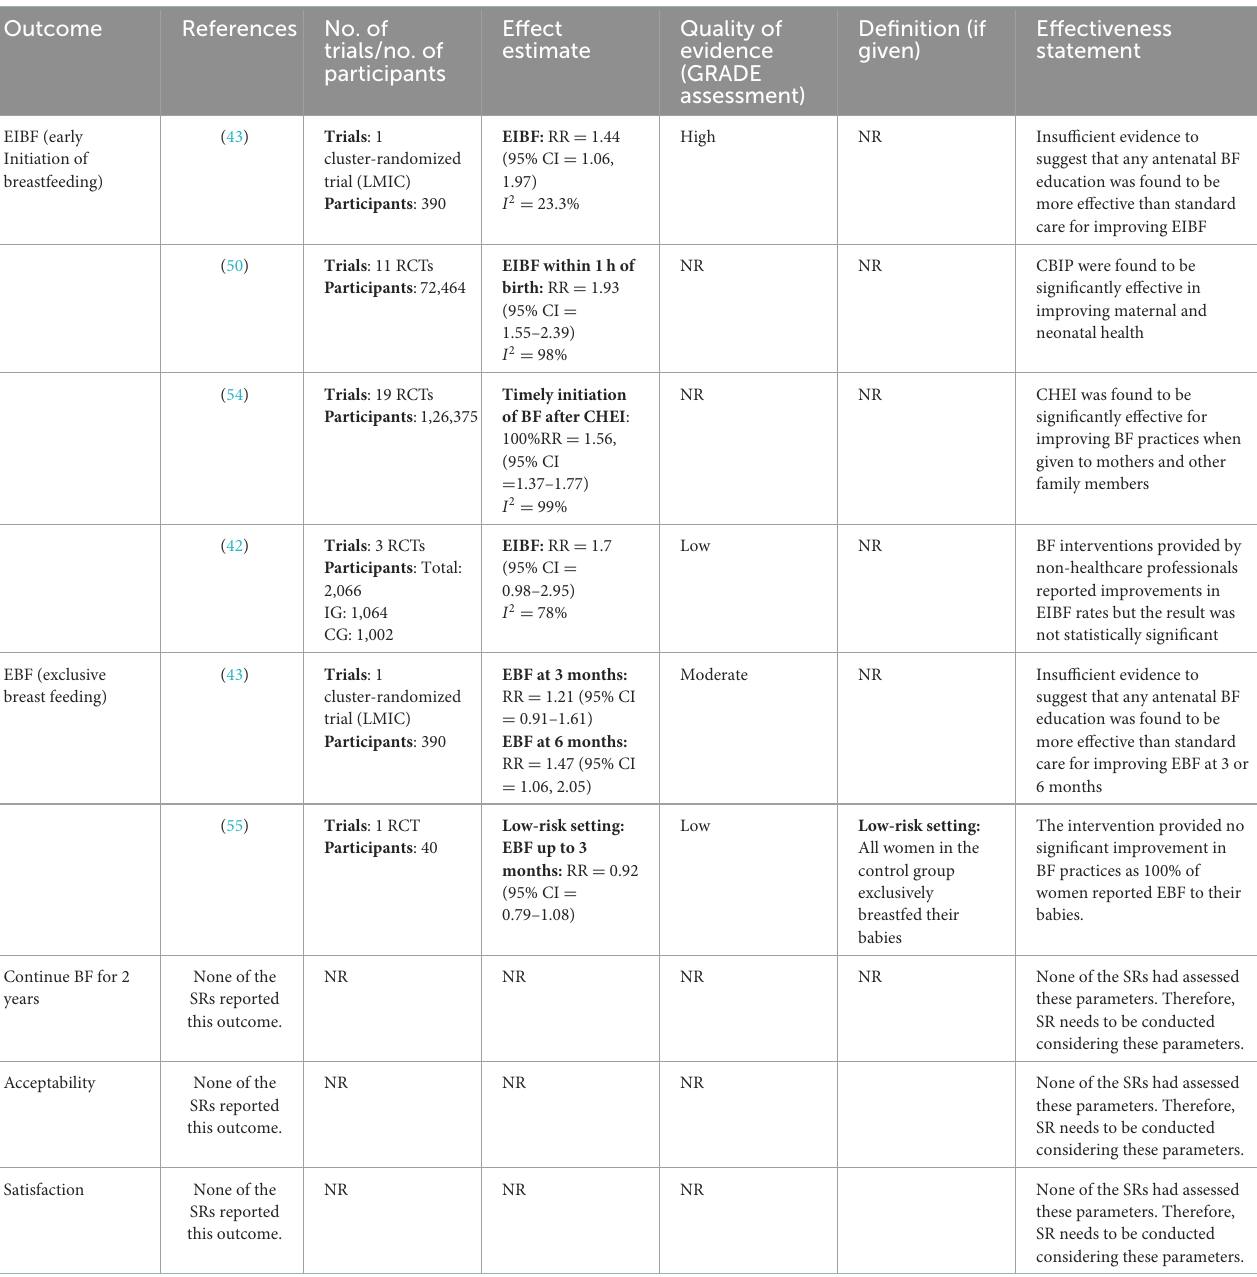
TABLE 2 Findings of included